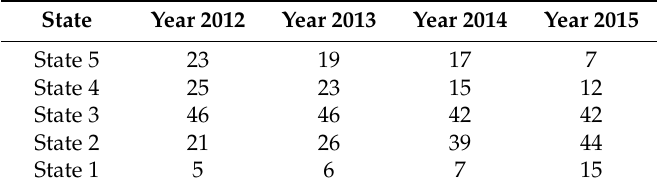
Table 4. Numbers of transformers in its consecutive states from 2012 to 2015.